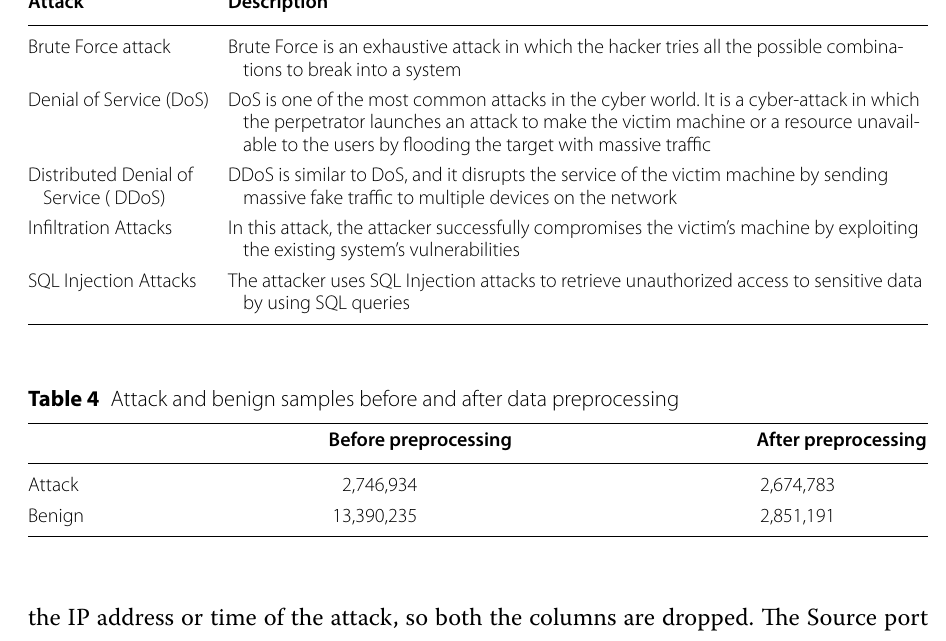
Table 3 The attacks in the dataset are broadly classified into 5 categories Attack